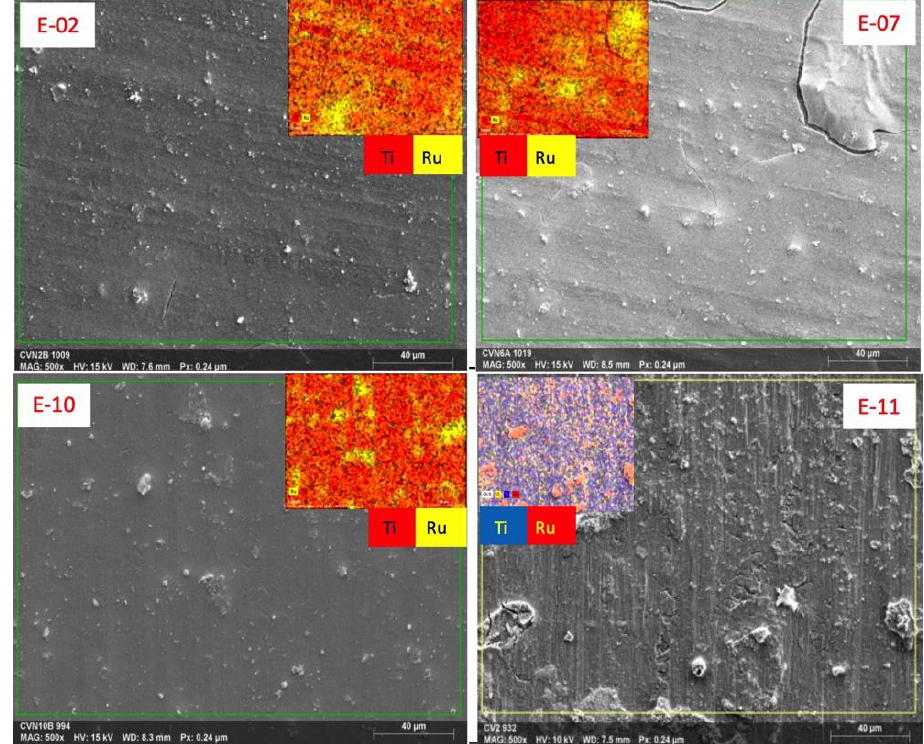
Figure 1. FE-SEM for some selected electrodes. Insets are the corresponding energy-dispersive X-ray spectroscopy (EDX) map.